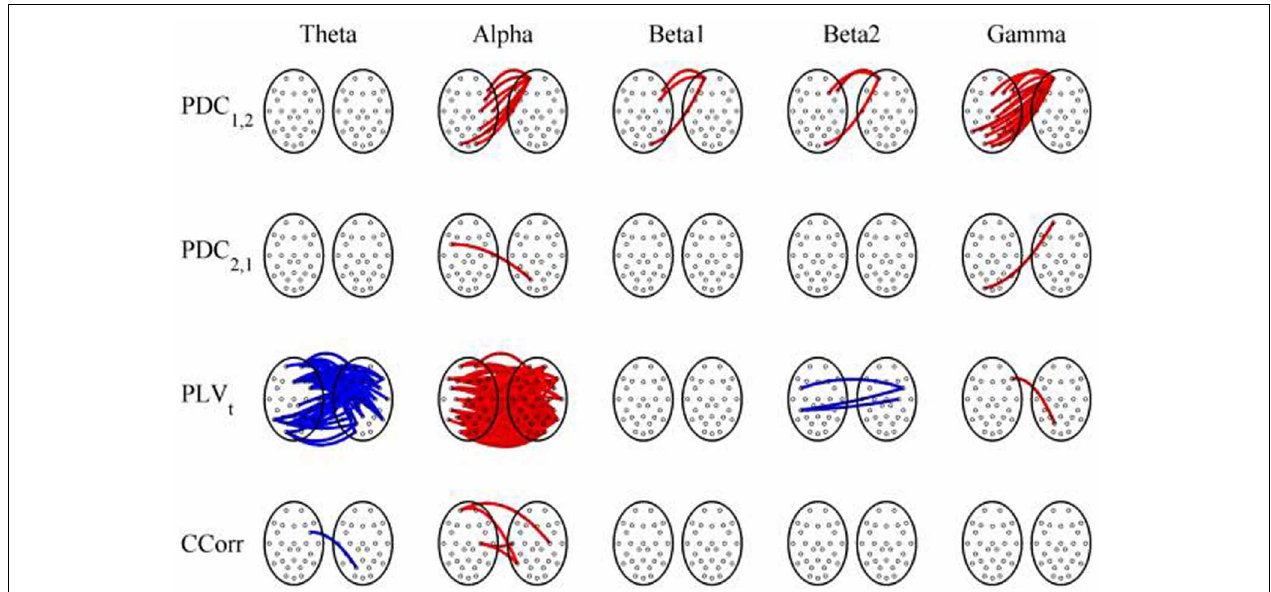
FIGURE 12 | Significant changes in mean time-averaged hyperconnectivity between eyes open and eyes closed resting states by connectivity measure and frequency band. The rows represent the hyperconnectivity results for each of the measures used (PDC 1 , 2 , PDC 2 , 1 , PLV t , and CCorr) and the columns represent the frequency bands (theta, alpha, beta1, beta2, and gamma). The pairs of large circles in each cell represent the heads of the participants in a pseudo-pair. The smaller circles indicate the topographical location of the EEG recording electrodes. For PLV t and CCorr, lines drawn between the heads joining electrode sites indicate